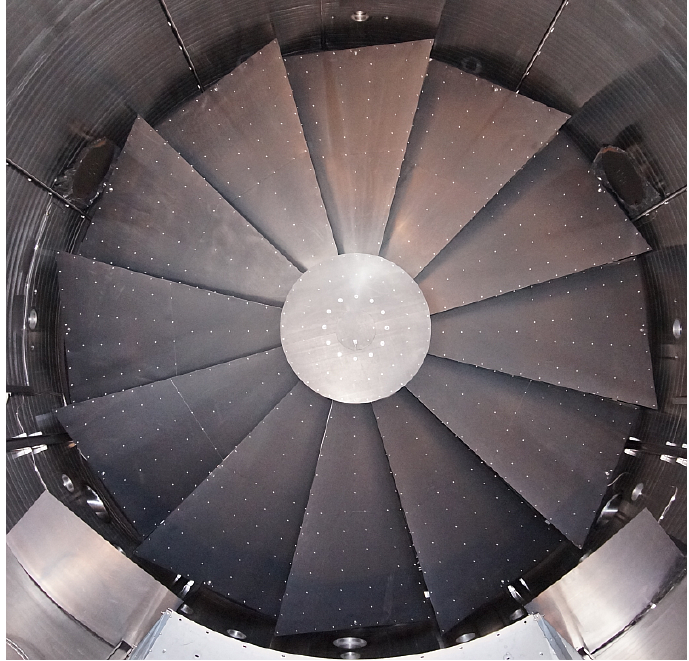
Figure 2: STG-ET beam dump target installed at the vacuum chamber end